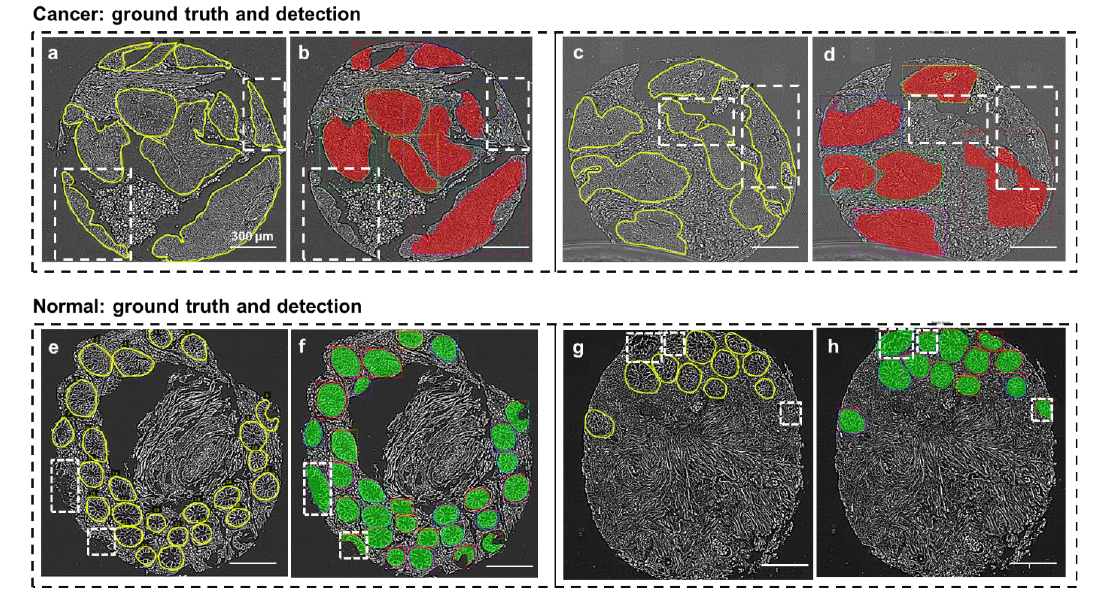
Figure 4. Examples of gland detection errors and additional positive detections. ( a ) Ground truth (manual) segmentation of cancer glands. ( b ) Network predictions showing regions in the dashed boxes that were missed. ( c , d ) A similar illustra- tion as in ( a , b ). ( e ) Ground truth (manual) segmentation of normal glands. ( f ) Network predictions showing regions in the dashed boxes that were additional true positives. ( g , h ) A similar illustration as in ( e , f ). Note that all errors and additions occurred at the boundaries of the cell cores.